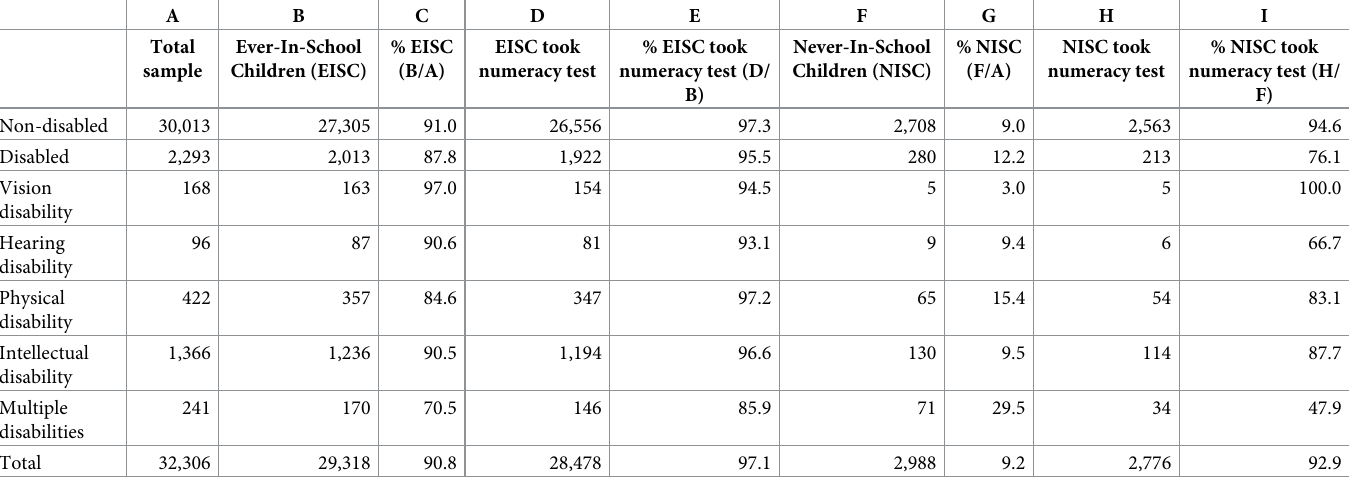
Table 1. Sample size by school status and disability